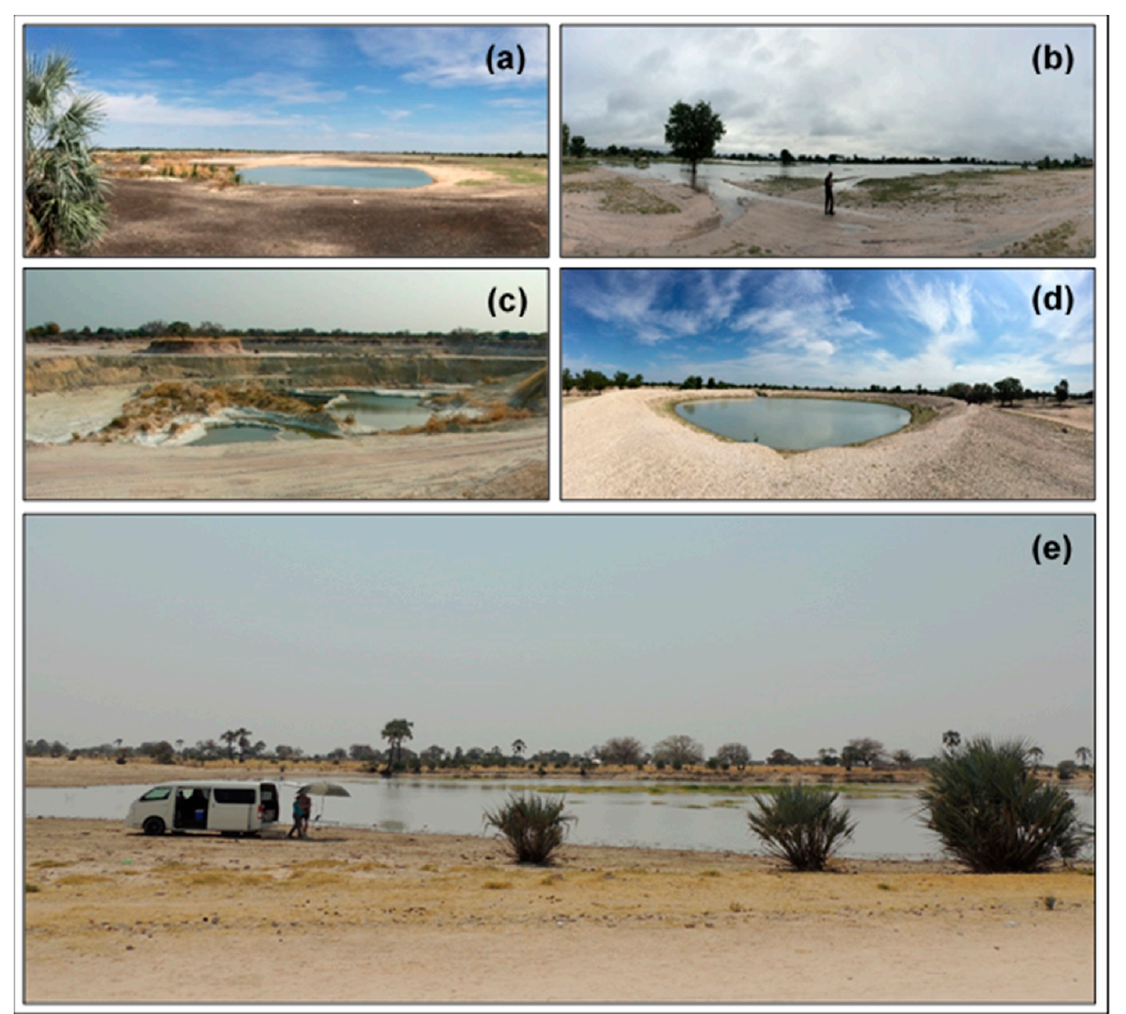
Figure 1. Typical hydrological landforms in the Iishana-System: ( a ) man-made deepened pan in an Oshana, ( b ) large pan in an Oshana, ( c ) borrow pit filled with groundwater, ( d ) artificial Stengel dam for water harvesting, and ( e ) typical Oshana with water filled pan, Sources: All photos by R. A.